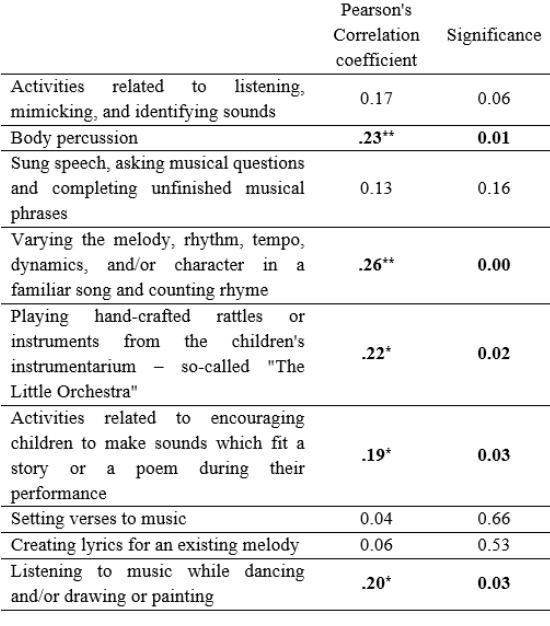
Table 7. Correlation of the